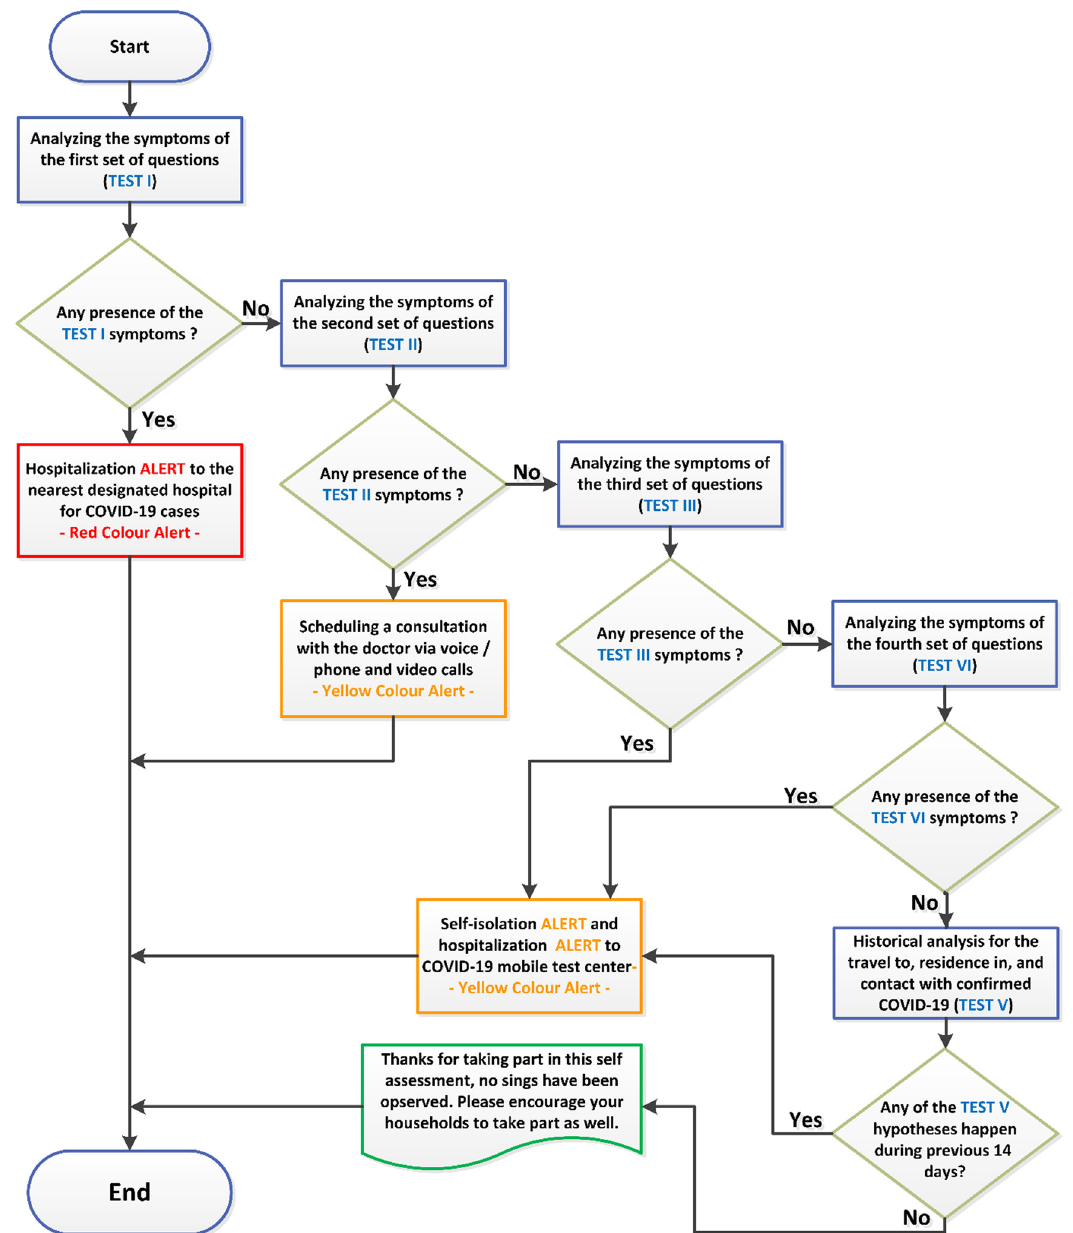
Figure 2: COVID - 19 self - assessment